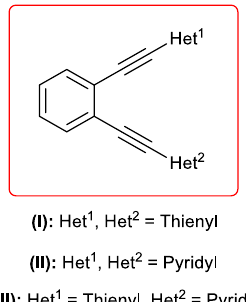
Figure 1. Rigid trans -spanning ligands used in Cu-free acyl Sonogashira protocol optimized by Sonoda et al.